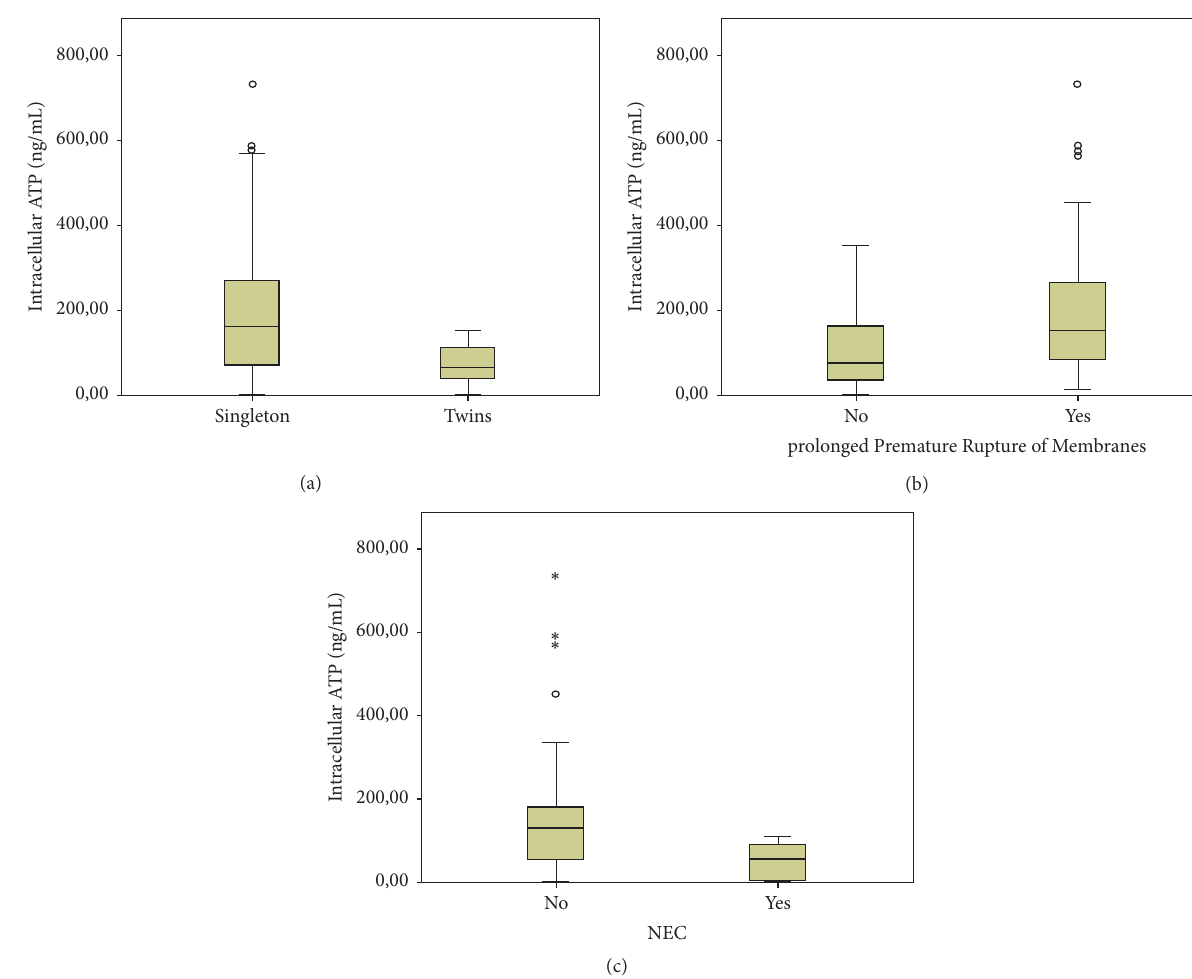
Figure 2: Levels of ATP at birth: (a) in twins and singleton; (b) pPROM versus other conditions of delivery; (c) patients with and without NEC. Outliers are marked as ∘ (“out values”: 1,5–3 × interquartile range, IQR) and ∗ (“extreme values”: > 3 × IQR).